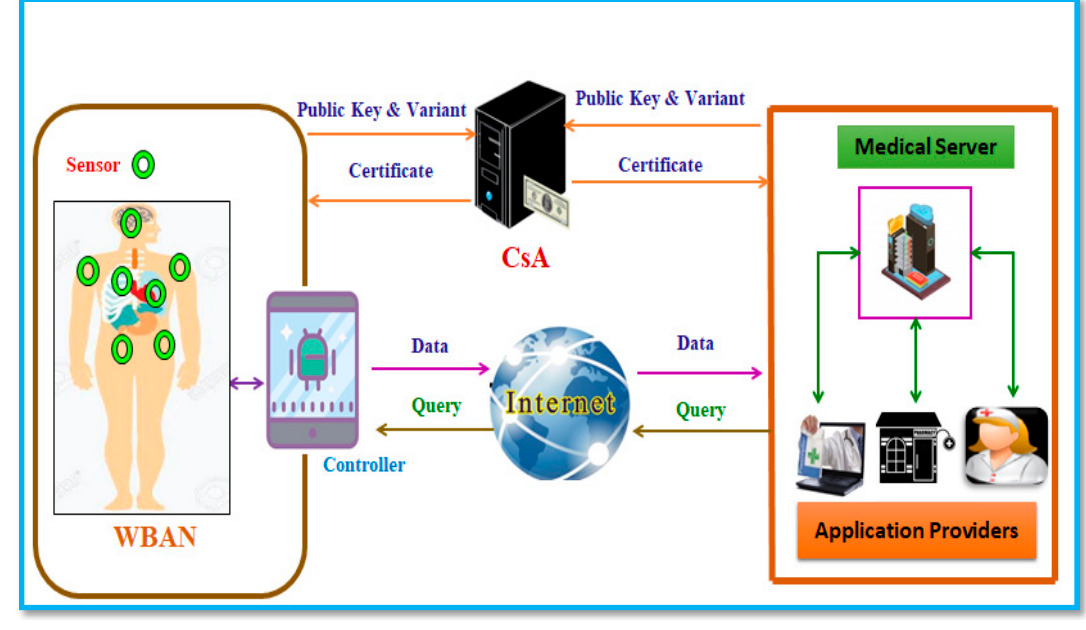
Figure 1. Proposed Figure 1. Proposed architecture. Table 1. Notations used in proposed algorithm.